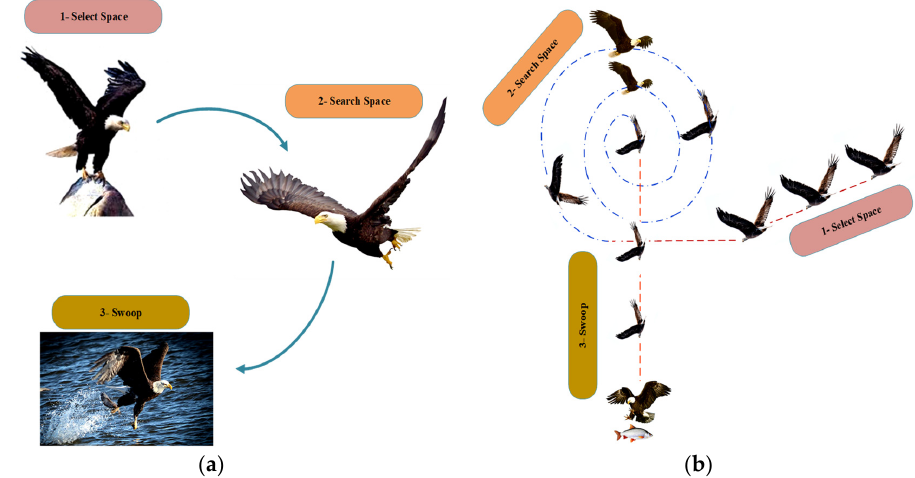
Figure 6. The TDM.